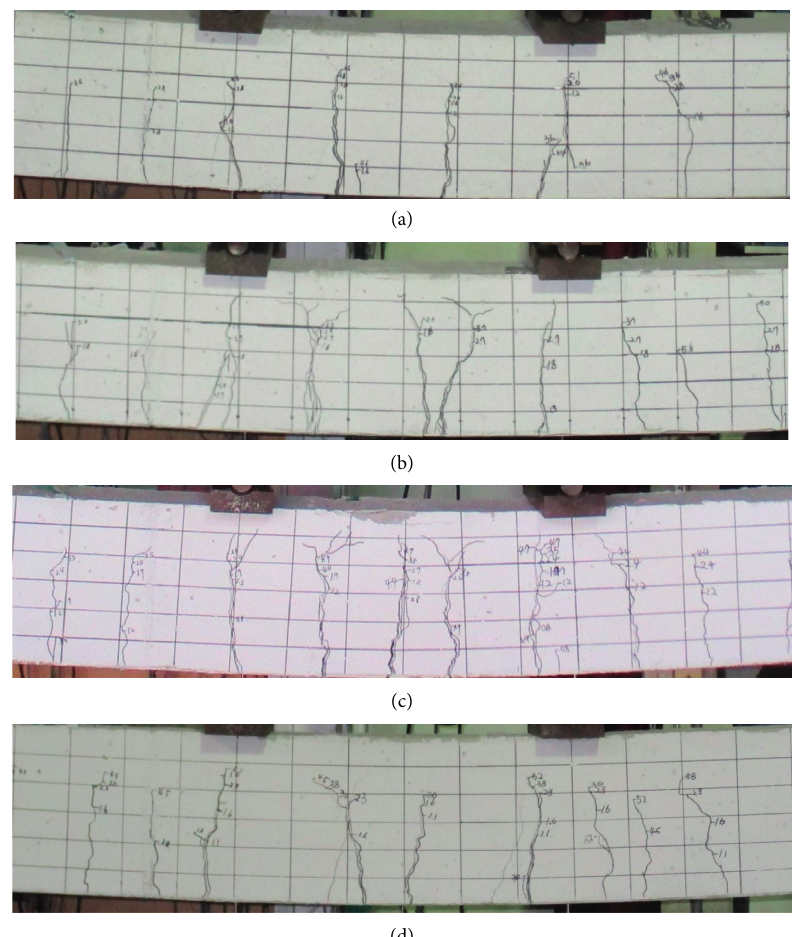
Figure 7: Typical crack failure patterns (S1 series beams). (a) Beam R030-S1. (b) Beam R030-S1. (c) Beam R050-S1. (d) Beam